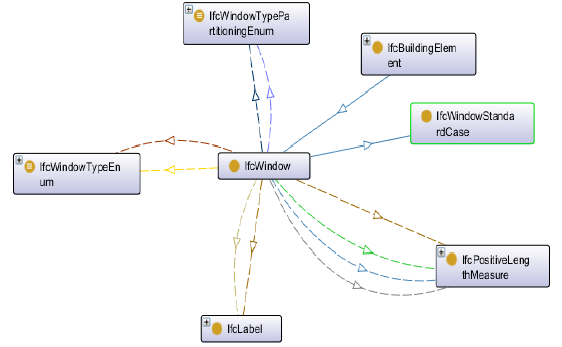
Figure 10. Inter-relationships between IFC entities.